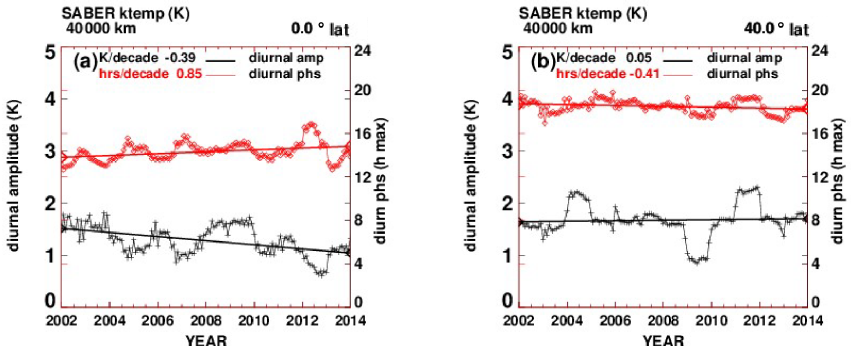
Figure A2. (a) Temperature tidal diurnal amplitudes and phases at 40km and the Equator. On the left axis scale, black line: tidal diurnal amplitude (K). On the right axis scale, red line: diurnal phase (h of maximum value). (b) As in (a) but at 40 ◦ N